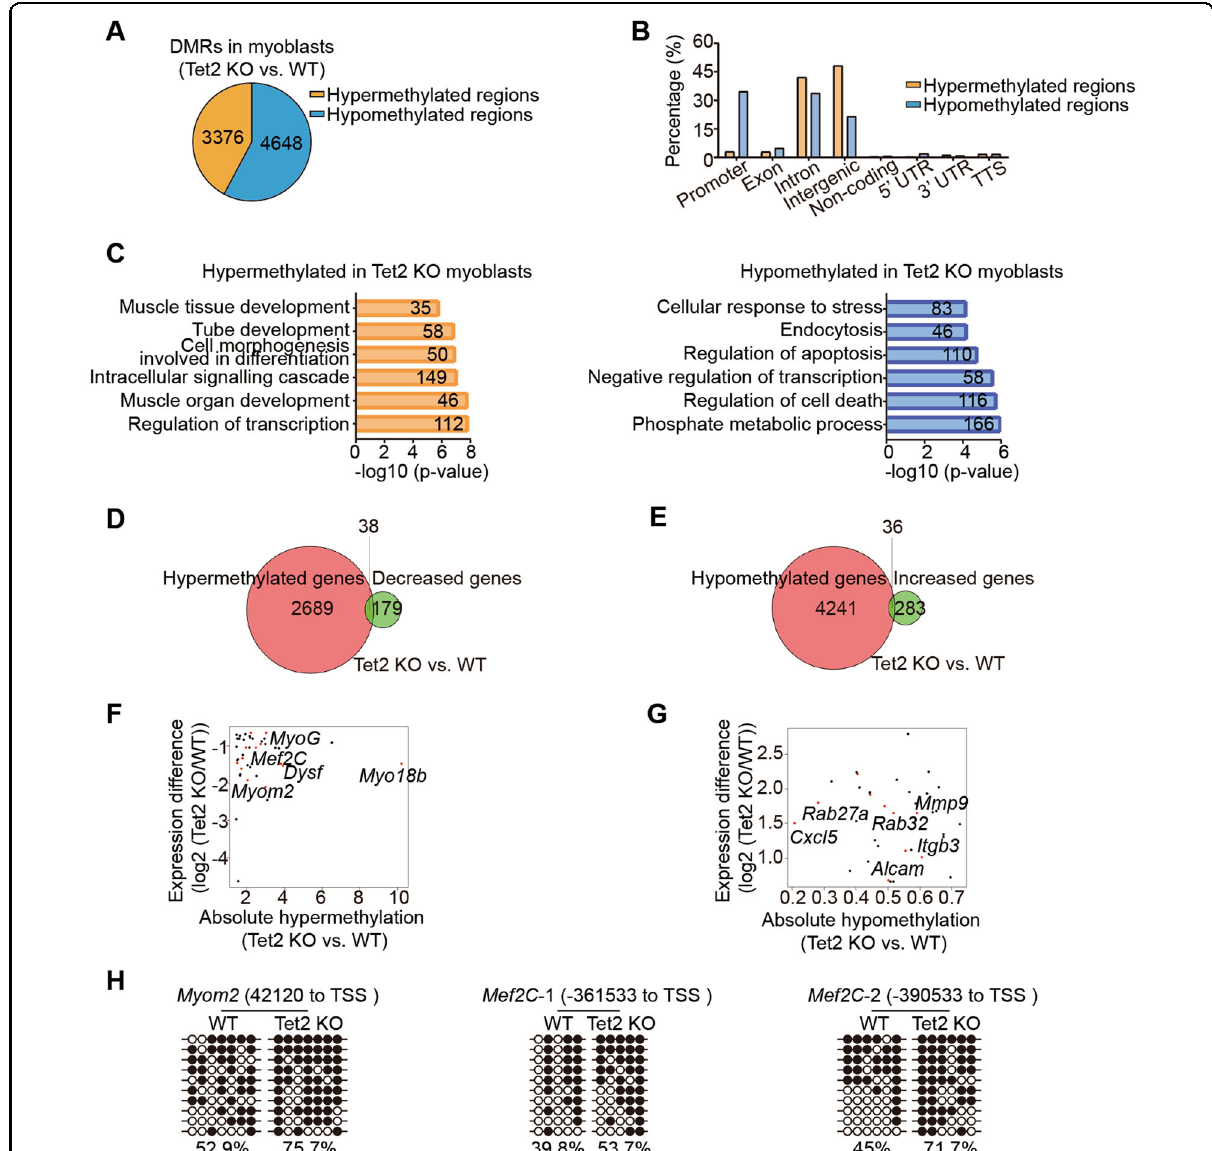
Fig. 4 The whole-genome methylation sequencing analysis of Tet2 KO myoblasts. A Pie chart indicated the differentially methylated regions (DMRs) of Tet2 KO myoblasts compared to those of WT myoblasts. B Distribution of the DMRs at various genomic features. C Gene ontology analysis of the DMRs. D Venn diagram of the hypermethylated and the downregulated genes in Tet2 KO myoblasts. E Venn diagram of the hypomethylated and the upregulated genes in Tet2 KO myoblasts. F Scatter plot of the genes hypermethylated and downregulated in Tet2 KO myoblasts. G Scatter plot of the genes hypomethylated and upregulated in Tet2 KO myoblasts. H The bisul fi te sequencing results of Myom2 and Mef2C in WT or Tet2 KO myoblasts. White and black circles indicated hypomethylated and hypermethylated CpG sites,